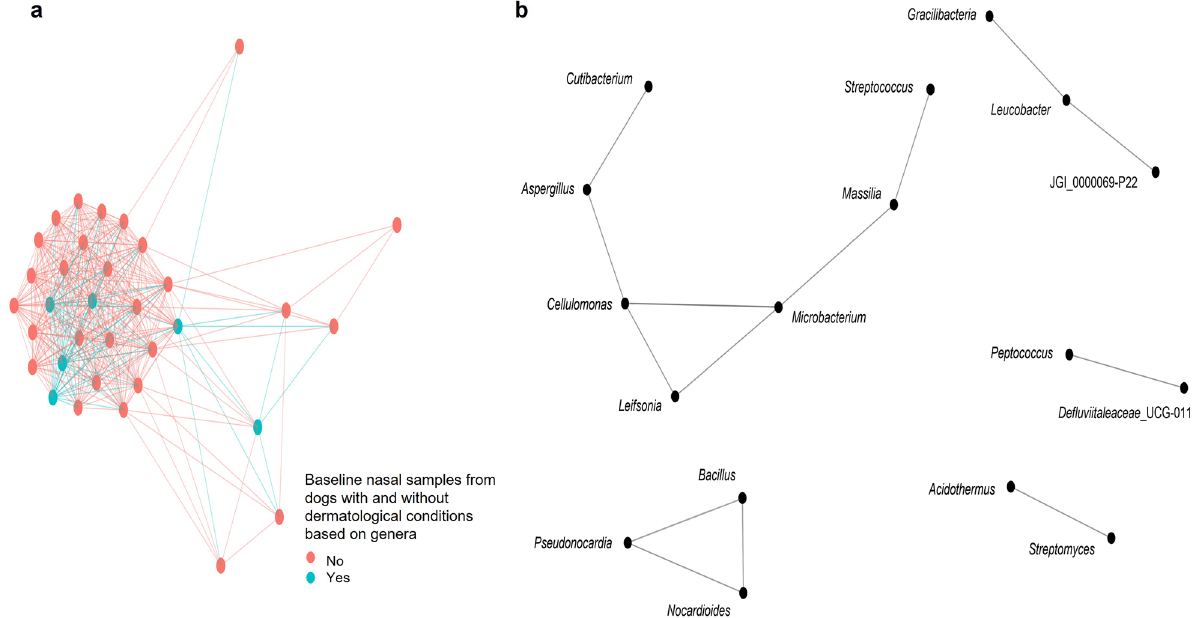
Figure 4. Co-occurrence network analysis using the genera with coefficient values from the elastic net logistic regression Model 1 (baseline nasal microbiota samples) using Bray–Curtis dissimilarly and maximum distance of 0.8 displaying the connections between (a) baseline nasal microbiota samples of dogs with (yes) and without (no) dermatological conditions and (b) the genera.